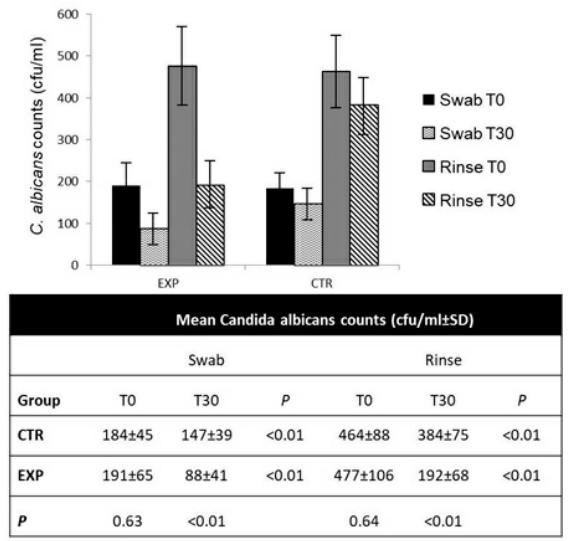
Figure 2. Candida albicans counts before (T0) and after 30 days treatment regimens (T30) with (EXP) and without (CTR) probiotic S. salivarius BLIS ® K12. C. albicans counts obtained by two distinct sampling procedures (swab and rinse) are represented in the plot and reported in the explanatory table as colony forming units / ml (CFU / mL) means ( ± standard deviation). Significance of di ff erences between